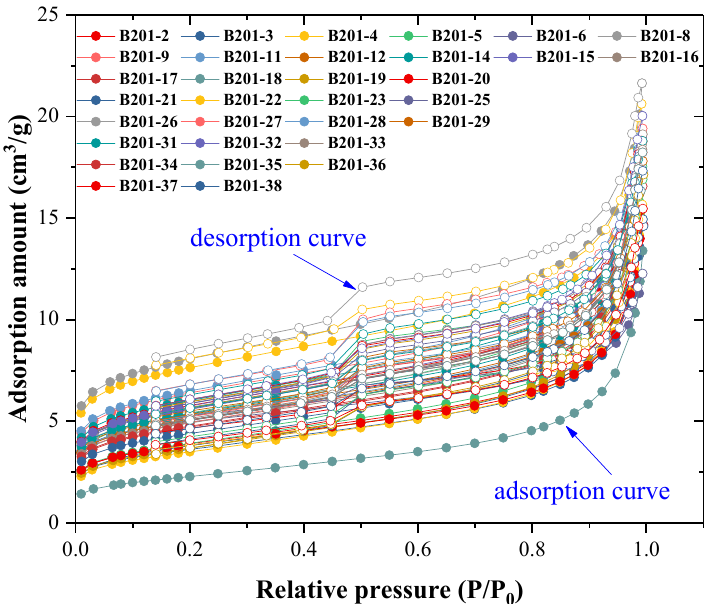
Figure 6. The experimental N 2 adsorption and desorption curves of shale samples from B201 well.